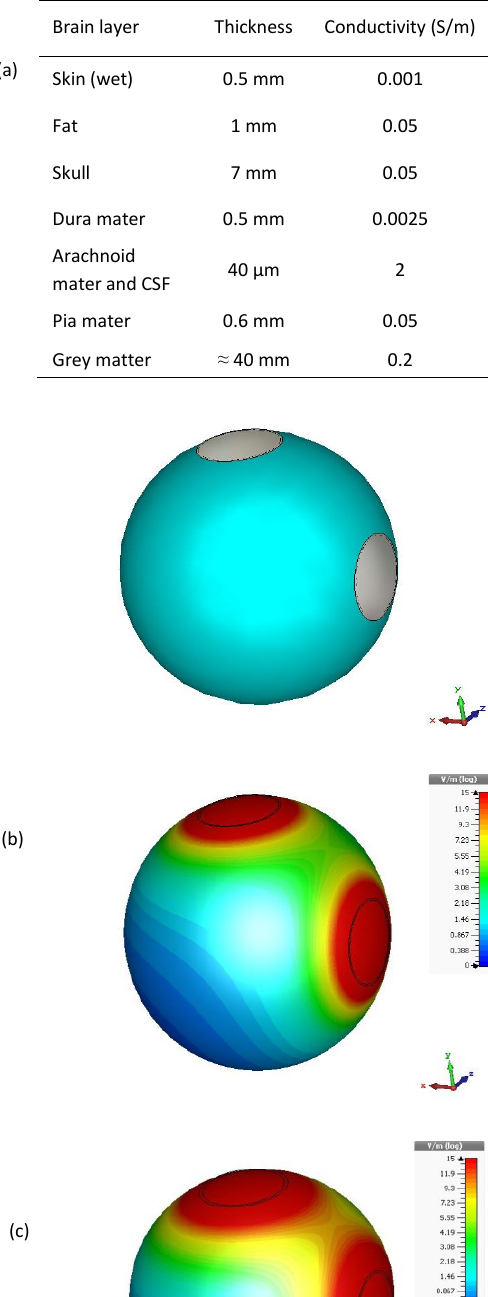
Table 1: Brain tissue dielectric